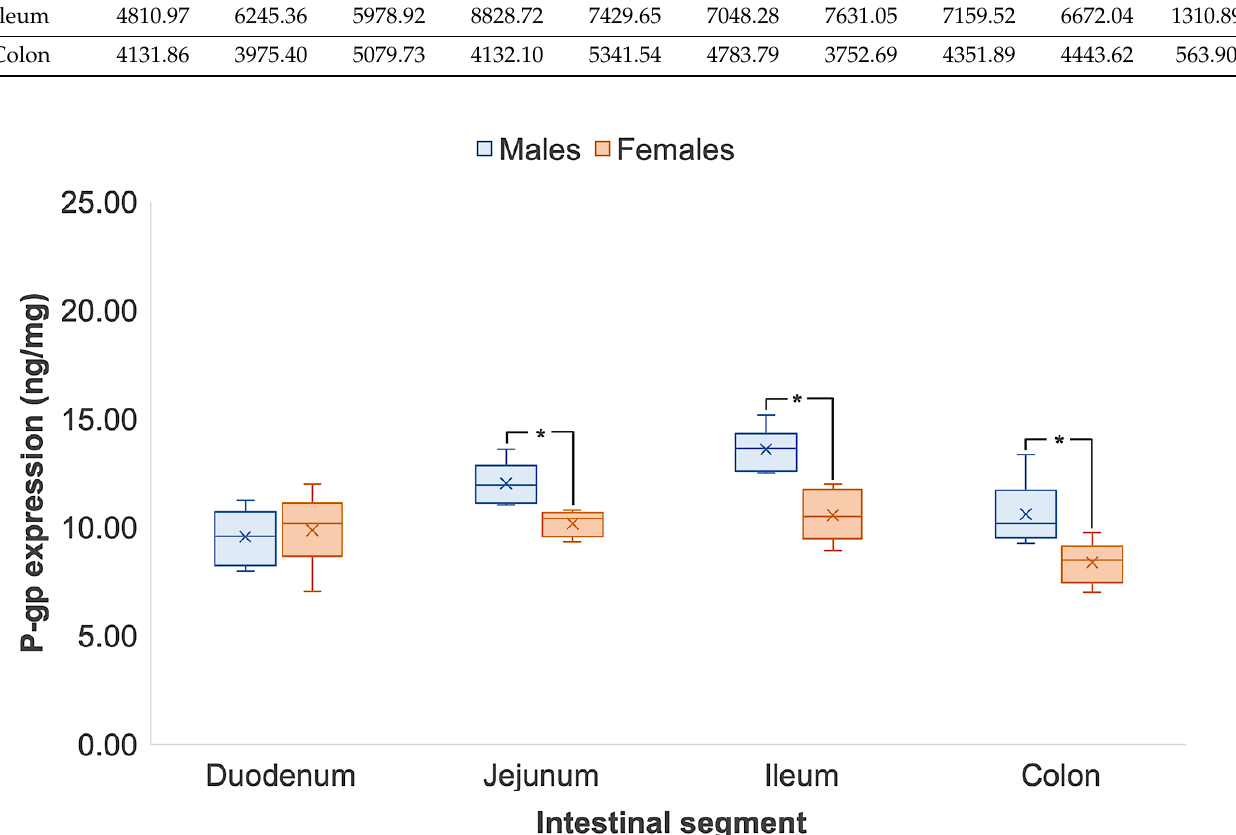
Figure 1. Regional and sex differences in P-gp expression in male and female Wistar rats quantified by ELISA. Data are represented as mean ± S.D., n = 8. The * symbol denotes statistical significance between the sexes in an intestinal region ( p < 0.05). Regional differences are statistically significant from the small intestinal segments to the colon ( p < 0.05).